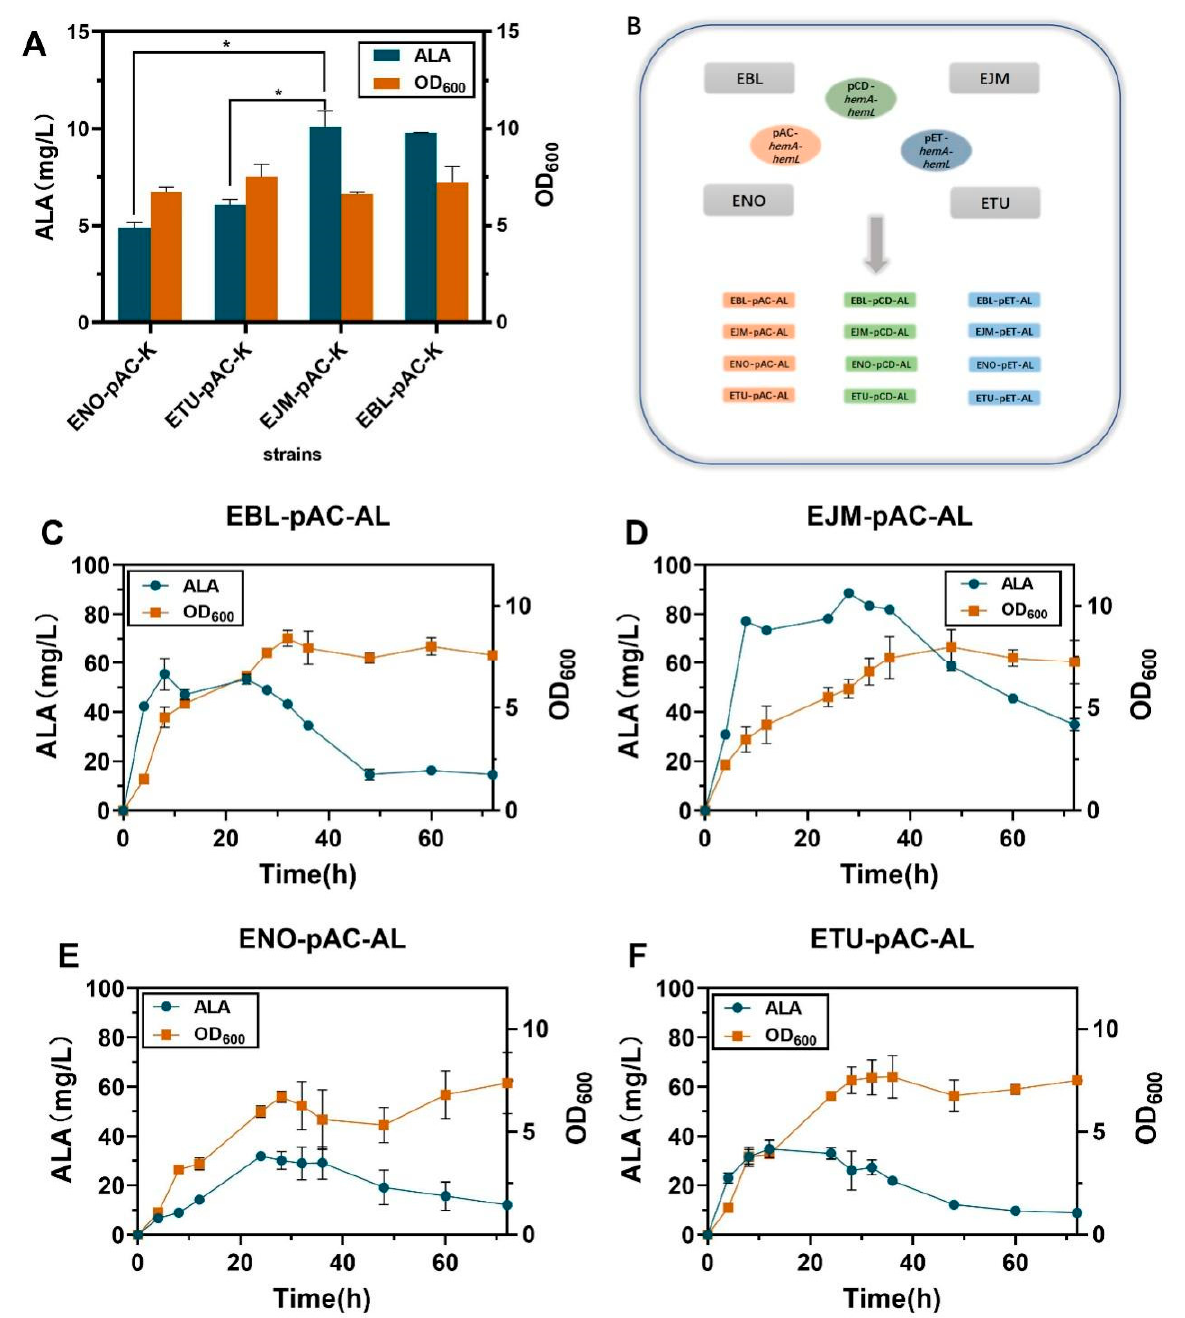
Figure 2. ( A ) OD 600 and ALA production of the no-loaded strains at 36 h of fermentation. ( B ) Recom- binant plasmid construction flowchart. ( C – F ) Growth curve and ALA production of recombinant strain fermented for 72 h. (The recombinant strains corresponding to Figure 2C–F are EBL-pAC-AL, EJM-pAC-AL, ENO-pAC-AL, ETU-pAC-AL, respectively). All data indicate the mean of two inde- pendent biological experiments and error bars represent standard deviation. The symbol * stands for and p < 0.05, as determined by Student’s t-test.